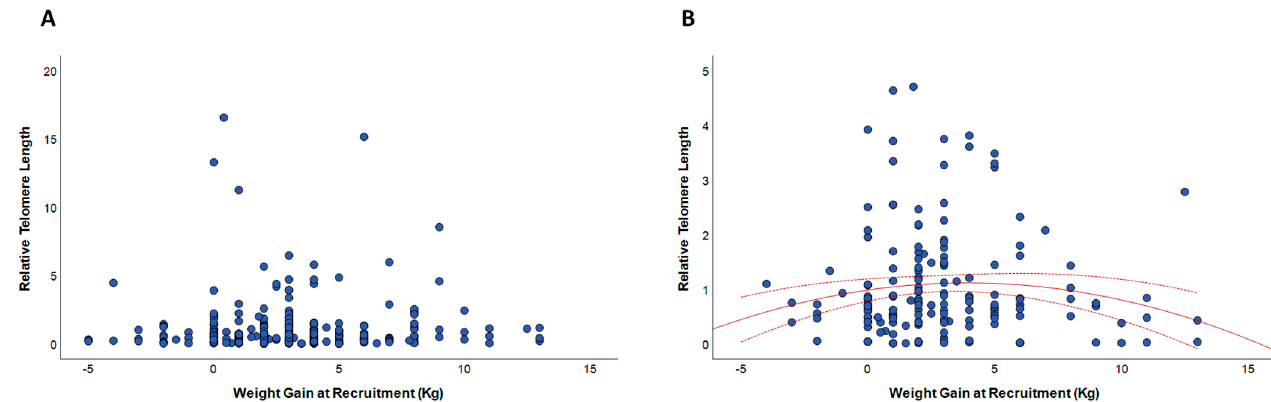
Figure 3. The relationship of weight gain at recruitment with relative telomere length. ( A ) shows the relationship of weight gain at recruitment with telomere length of mlDNA; ( B ) shows the relationship of weight gain at recruitment with telomere length of cfDNA from amniotic fluid.